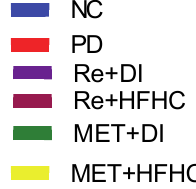
Figure 10. Fluid intake volume in normal control (NC), prediabetic control (PD), metformin and diet intervention (MET + DI), metformin and high-fat/high-carbohydrate diet (MET + HFHC), rhenium (V) compound and diet intervention (Re + DI) and rhenium (V) compound and high-fat/high-carbohydrate diet (Re + HFHC) groups after 12 weeks of treatment. Values are presented as means ± SEM (n = 6). (cid:70) p < 0.05 in comparison with NC; # p < 0.05 in comparison with PC, MET + DI, MET + HFHC, Re + DI and Re + HFHC.